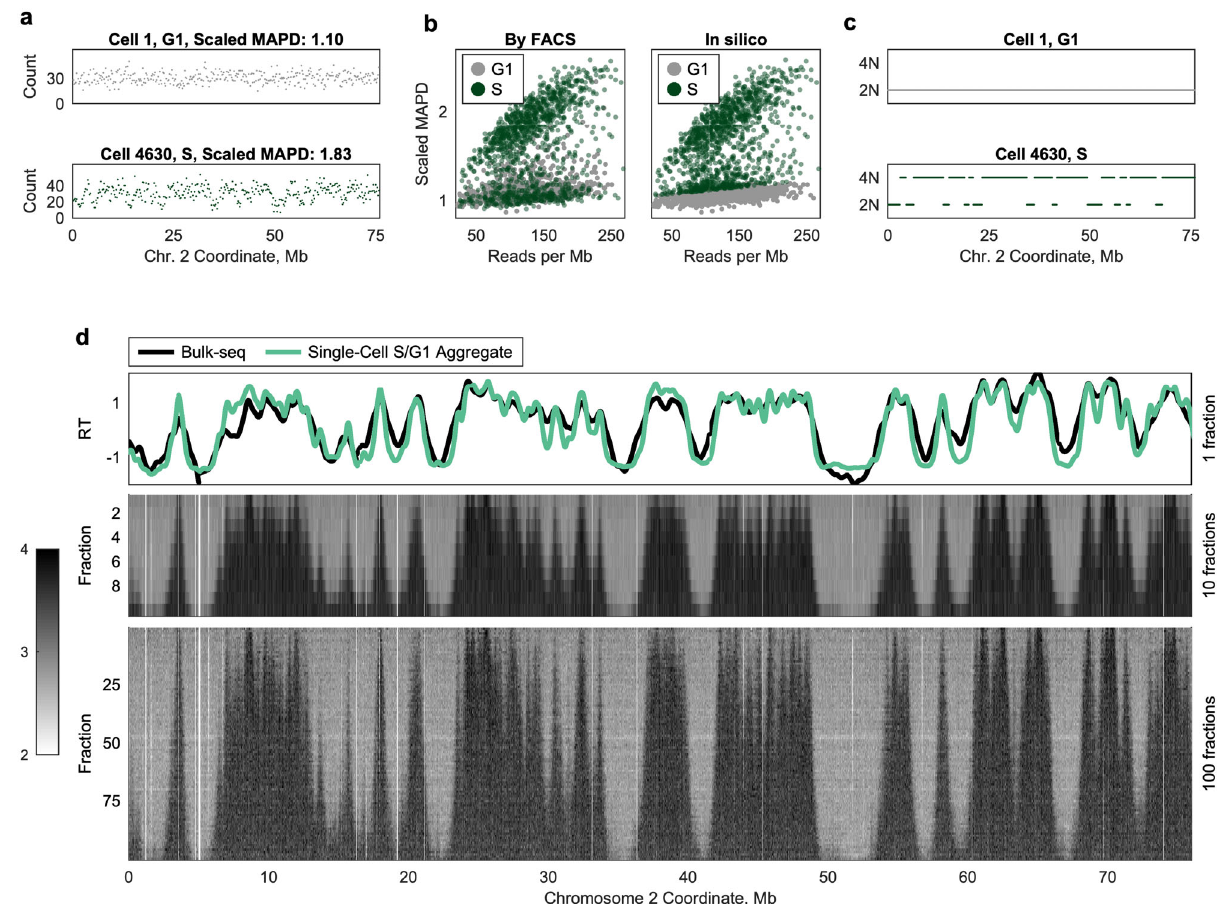
Fig. 1 Discrimination of replicating and nonreplicating cells by in silico fl ow cytometry. a Nonreplicating G 1 -phase cells (e.g., Cell 1) display relatively uniform read depth across the genome, whereas S-phase cells (e.g., Cell 4630) display fl uctuations in read depth, consistent with two underlying copy- number states. Dots represent read count in 200 kb windows. b Flow-sorted single cells ( left ) can be accurately sorted in silico ( right ). Replicating S-phase cells display a higher degree of read-depth fl uctuation relative to nonreplicating G 1 -phase cells sequenced to equivalent coverage (quanti fi ed by scaled MAPD, median absolute pairwise difference between adjacent genomic windows). Left : cells are labeled as G 1 - (gray) or S-phase (green) based on FACS. Only G 1 - and S-phase fractions are shown. Right : the same cells are labeled as G 1 or S based on scaled MAPD, revealing widespread cross-contamination. c Replication pro fi les were inferred for each single cell, using a two-state hidden Markov model. Nonreplicating cells (e.g., Cell 1) display a single copy number (2N), while replicating cells (e.g., Cell 4630) display two distinct copy-number states (2N, 4N). Dots represent inferred replication state in 20 kb windows. The same region is shown from a . d Aggregating data across S-phase cells into one or more fractions reveals a consistent structure of replication progression at different times in S phase. Top : ensemble replication timing inferred from all S-phase cells (green) was highly correlated with bulk- sequencing replication timing for the same cell line (black). Middle, bottom : single cells were aggregated into 10 or 100 fractions based on S-phase progression. Triangular pileups of high read depth (caused by replication in most/all cells in the fraction) are observed in discrete locations across the chromosome, suggesting bidirectional replication progression originating at fi xed loci. Each row represents one fraction (containing multiple cells). Columns represent 20 kb windows. Low-mappability regions (white) have been